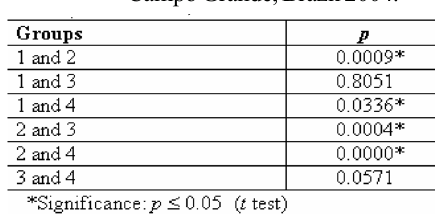
TABLE 2 - Paired comparison of TGFbeta2 expression in the groups.